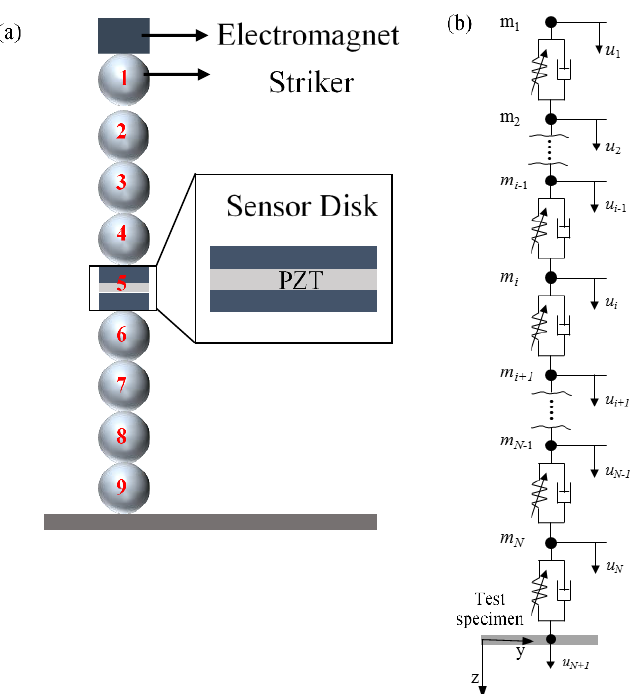
Figure 14. Modeling the interaction between the granular chain and the test specimen. ( a ) Schematics of the HNSW transducer with particle site number. ( b ) Schematic of the mono-periodic array as a series of point masses interacting via nonlinear Hertzian contact (In this figure, N = 9).